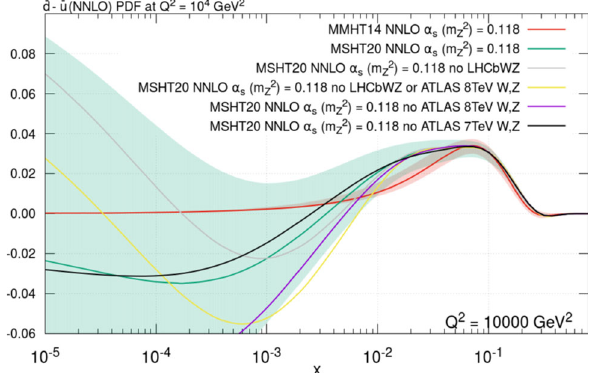
Fig. 67 ¯ d −¯ u PDFat Q 2 = 10 4 GeV 2 ,showingtheeffectsofremoving separately various of the ATLAS and LHCb W , Z data sets. Central values and uncertainty bands are included in for the default MSHT20 and MMHT14 plots, whilst only central values are given for the cases with data sets removed from MSHT20